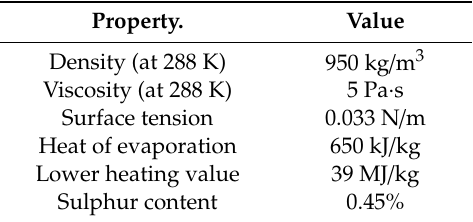
Table 2. Physical properties of heavy fuel oil (HFO) at room